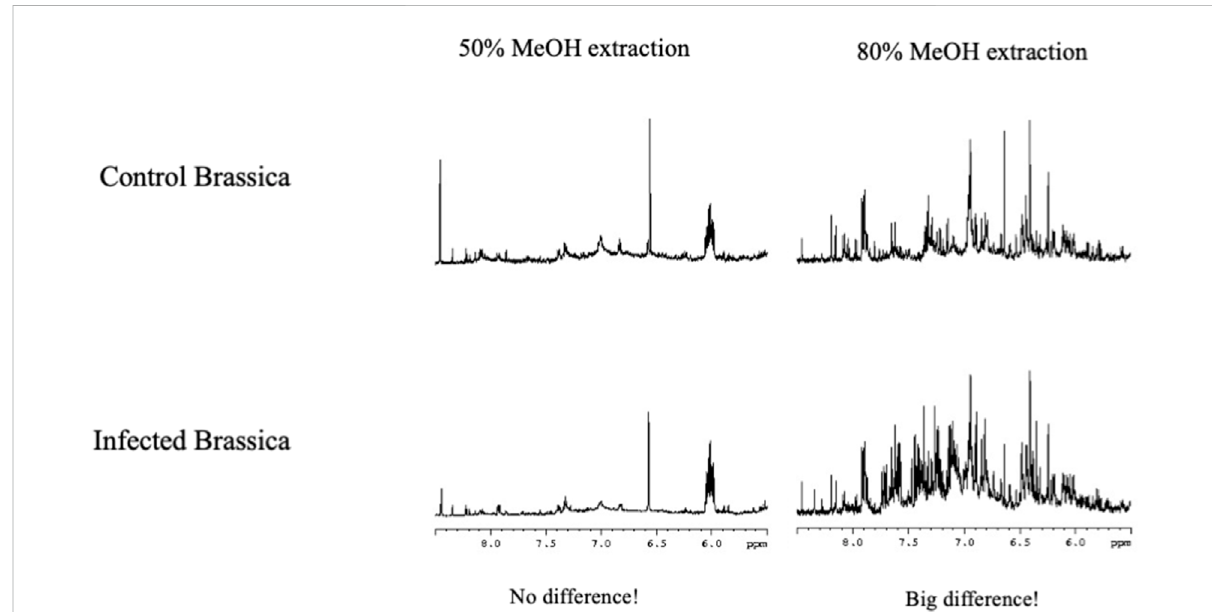
FIGURE 7 Difference between NMR metabolomics data depending on the extraction solvent. Control Brassica nigra and infected Brassica nigra leaves were extracted using two different solvents containing 50% MeOH (A) and 80% MeOH (B) . There was less differences between control and